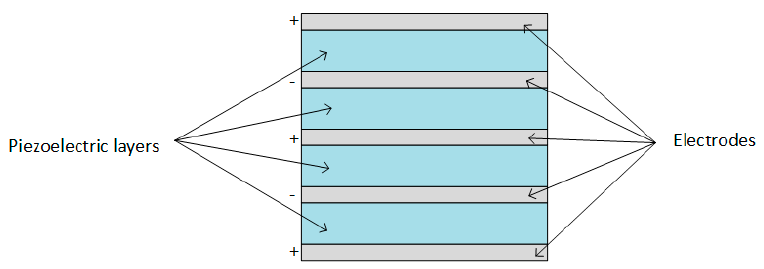
Figure 7. Cymbal transducer.